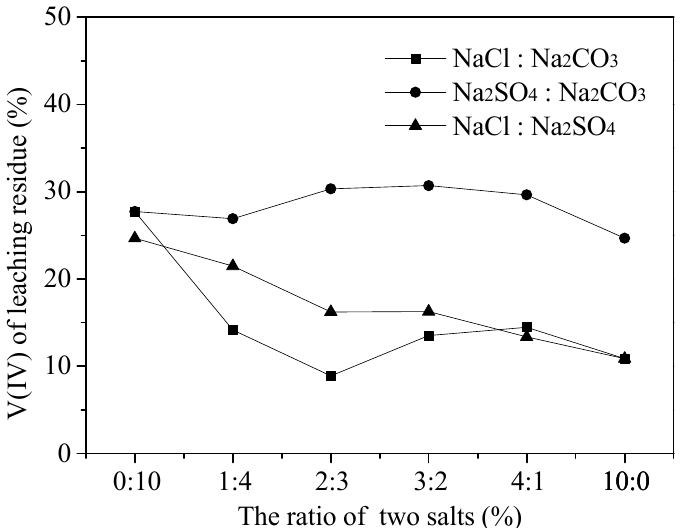
Figure 2. The V(IV) of leaching residue of composite additives of two sodium salts.